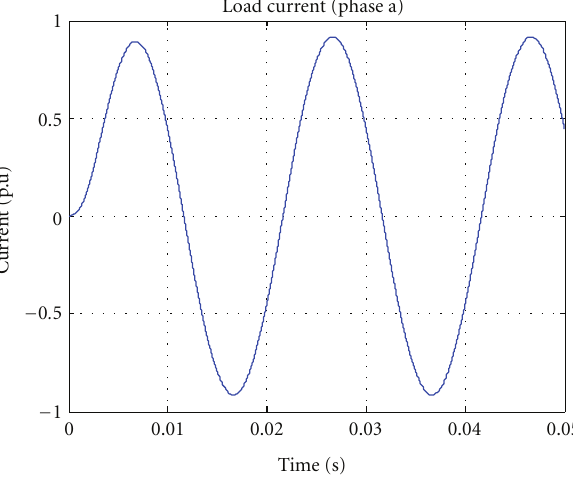
Figure 8: Inverter output phase voltage, v a , before the filter.